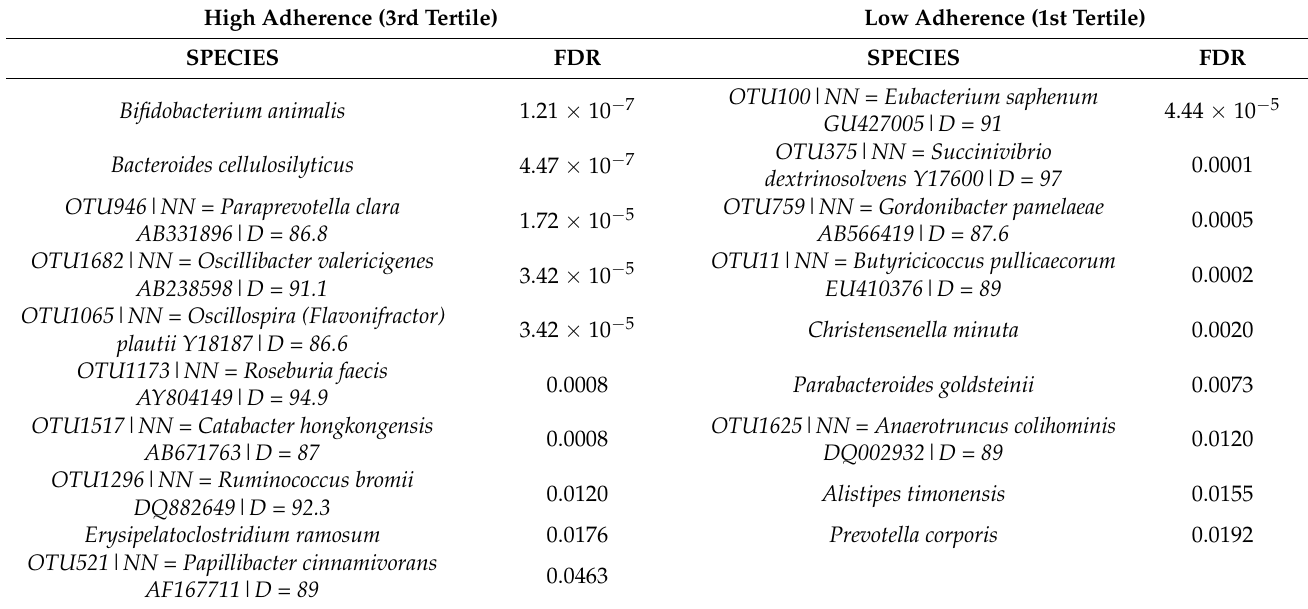
Table 2. Bacterial species with a significant relation with adherence to the MD (FDR (False discovery rate) < 0.05) by metagenomeSeq